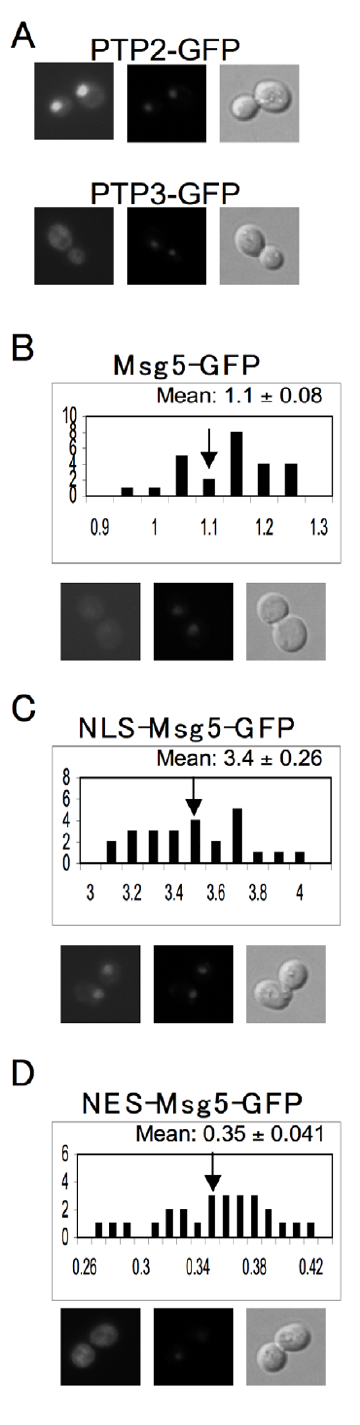
Figure 3 Localization of the wild type, NLS-tagged, and NES-tagged forms of Msg5 . A set of 15Dau transformants carrying various cen- tromeric reporter plasmids–PTP2-GFP, PTP3-GFP, MSG5-GFP, NLS-MSG5 M45A -GFP, and NES-MSG5 M45A -GFP–were grown to mid-log phase, stained with 20 μ g/ml DAPI, and examined using fluorescent and differential interference contrast (DIC) microscopy. In each panel, representative images are displayed as follows: FITC (left), DAPI (middle), and DIC (right). RNCF values for Msg5-GFP, NLS-MSG5 M45A - GFP, and NES-MSG5 M45A -GFP were quantified in the same manner as for Fus3-GFP, and are represented as histograms. RNCF values are indicated as the mean ± s.d. (A)PTP2-GFP cells (top); PTP3-GFP cells(bottom); (B)MSG5-GFP cells; (C)NLS-MSG5 M45A -GFP cells; (D)NES- MSG5 M45A -GFP